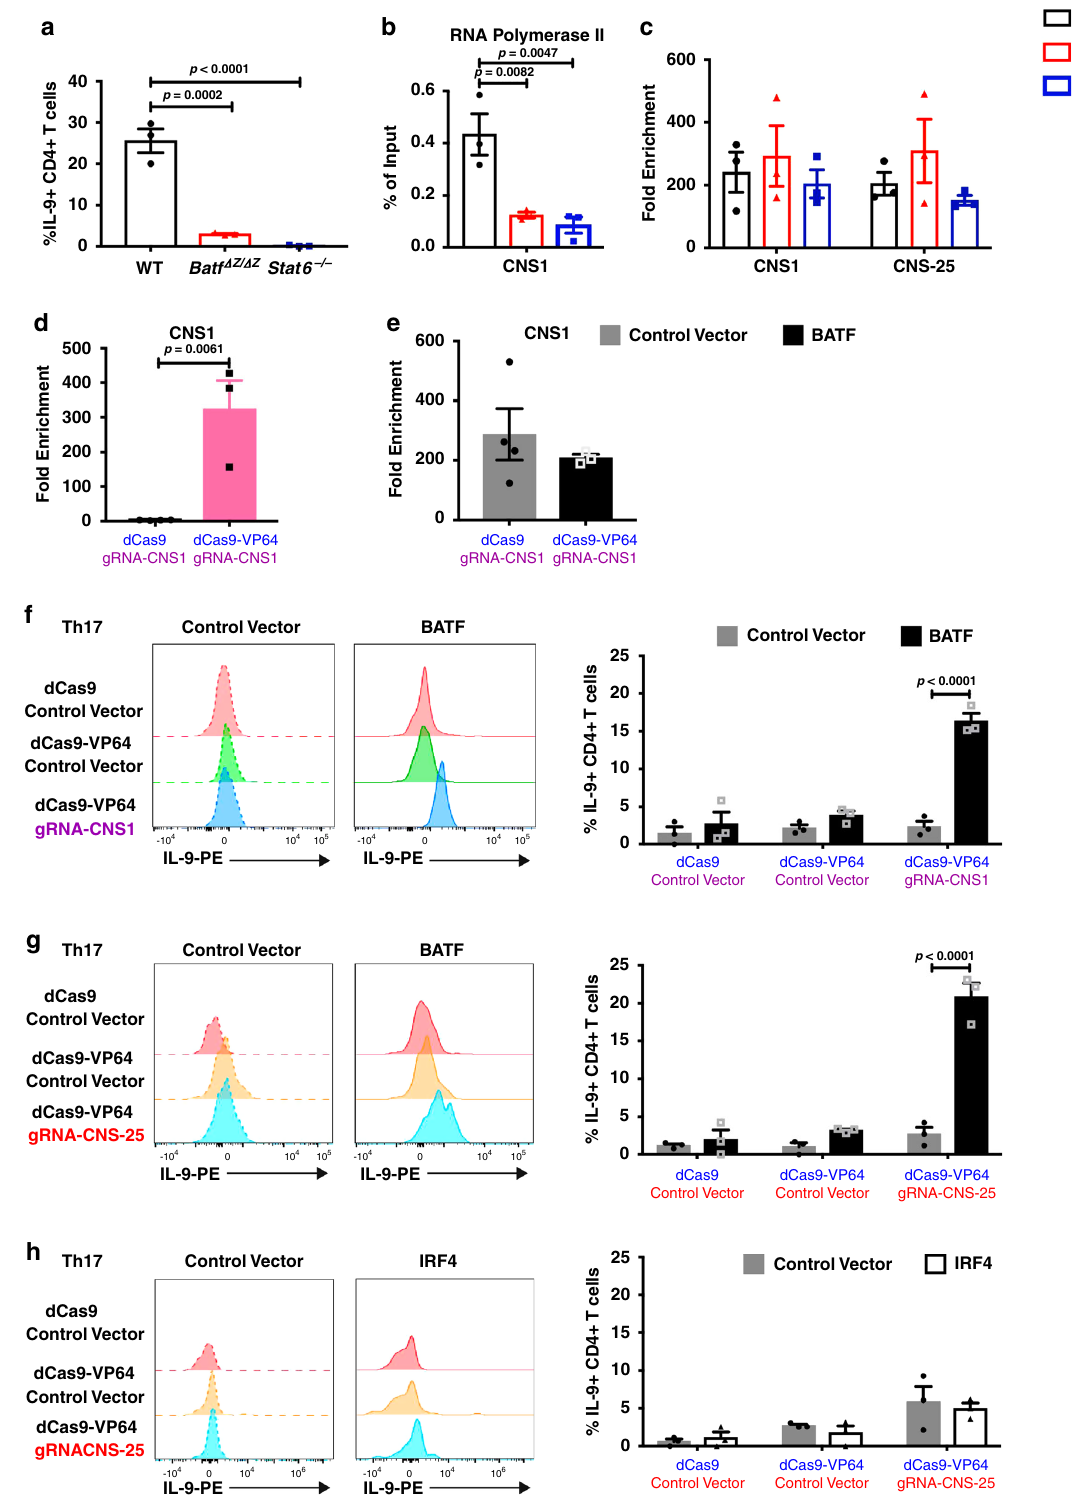
amounts of the repressive H3K27 trimethyl modi fi cation (Fig. 1h). Together, these data demonstrated distinct chromatin states at the Il9 locus in Th9 and Th17 cells. was necessary or suf fi cient to remodel chromatin at the Il9 locus.